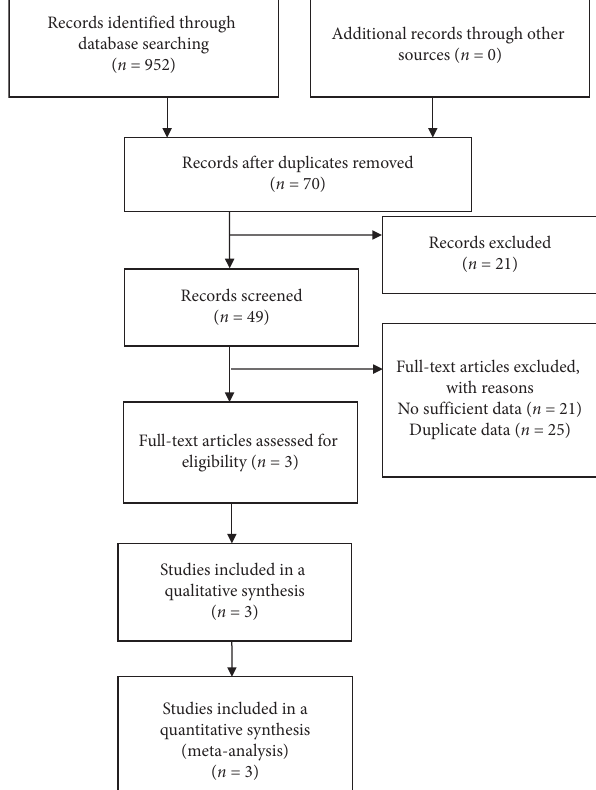
Figure 1: Flow chart of trial selection.